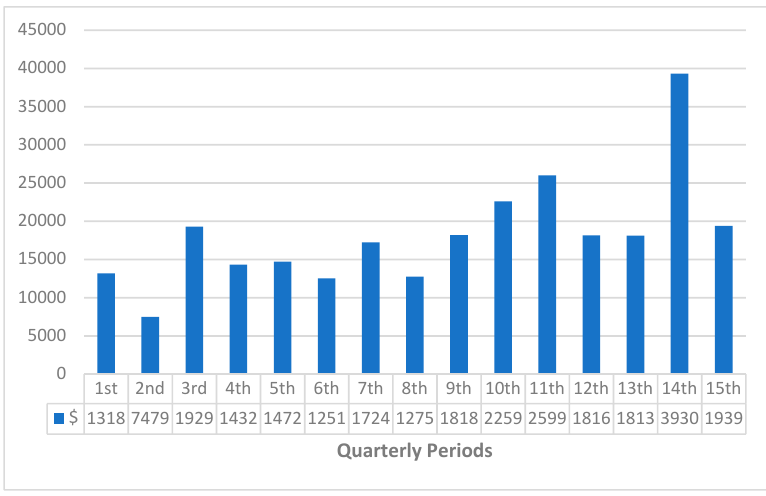
Figure 8. Loss due to downtime of pusher cylinder across investigated periods.